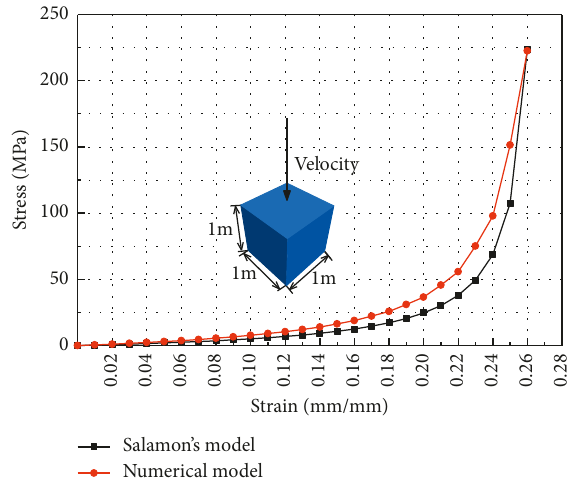
Figure 9: Gob stress-strain curves of numerical and Salamon’s